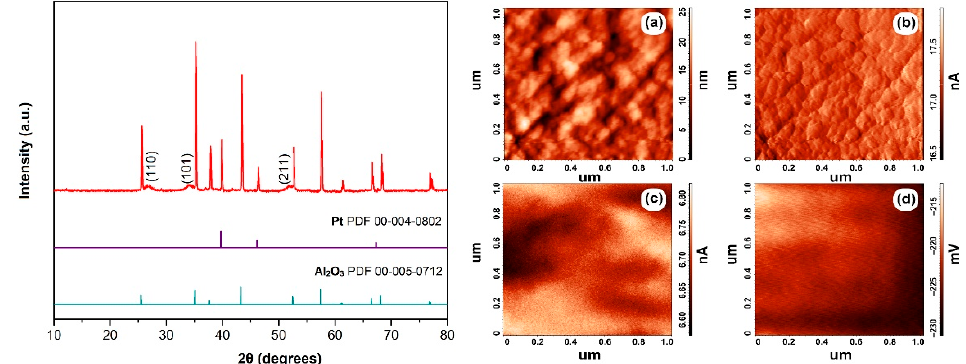
Figure 5. XRD pattern of the SnO 2 film on the surface of a specialized Pt/Al 2 O 3 /Pt chip ( left ), as well as AFM results ( right )—topography ( a ) and amplitude mismatch mode during topography imaging ( b ), capacity distribution map ( c ) and surface potential distribution ( d ).